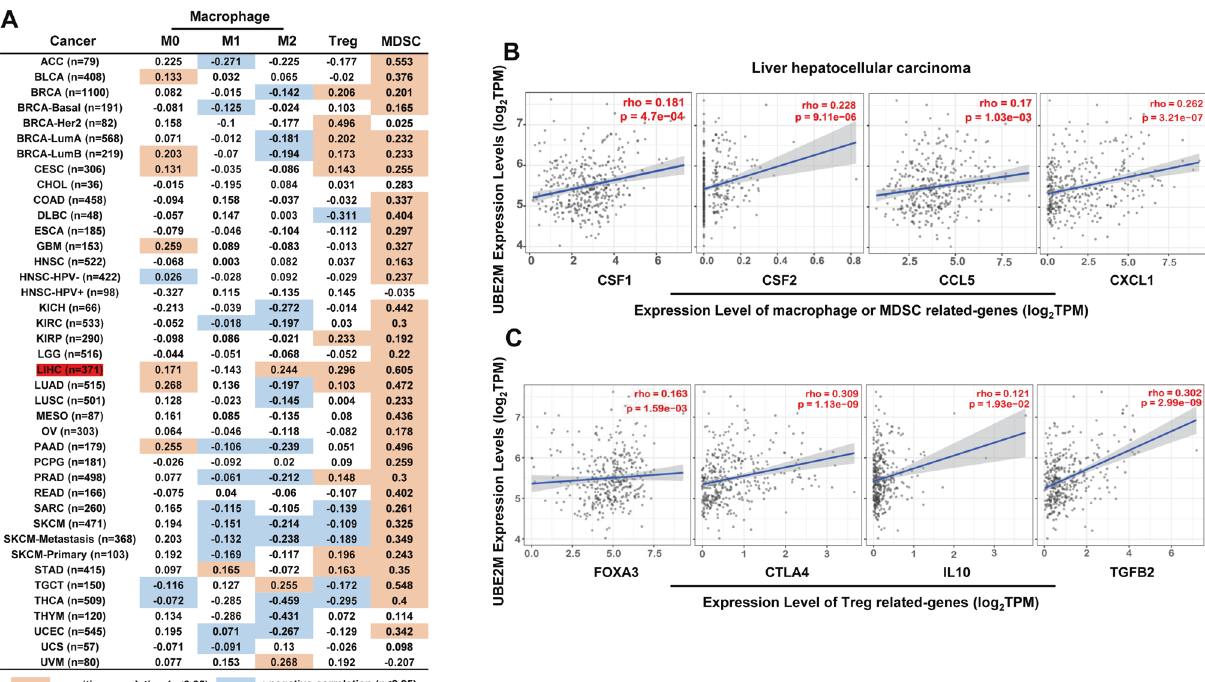
Fig. 5 The correlation of UBE2M and immune suppressive cell populations. A Graphs generated from TIMER database show the correlations between UBE2M and the abundance of macrophage, Treg, and MDSCs. B , C The expression of UBE2M was signi fi cantly correlated with multiple genes that are related to macrophage M2, MDSCs, or Treg in liver hepatocellular carcinoma. Spearman correlation analysis was used to assess the correlation. P < 0.05 was considered as statistical signi fi